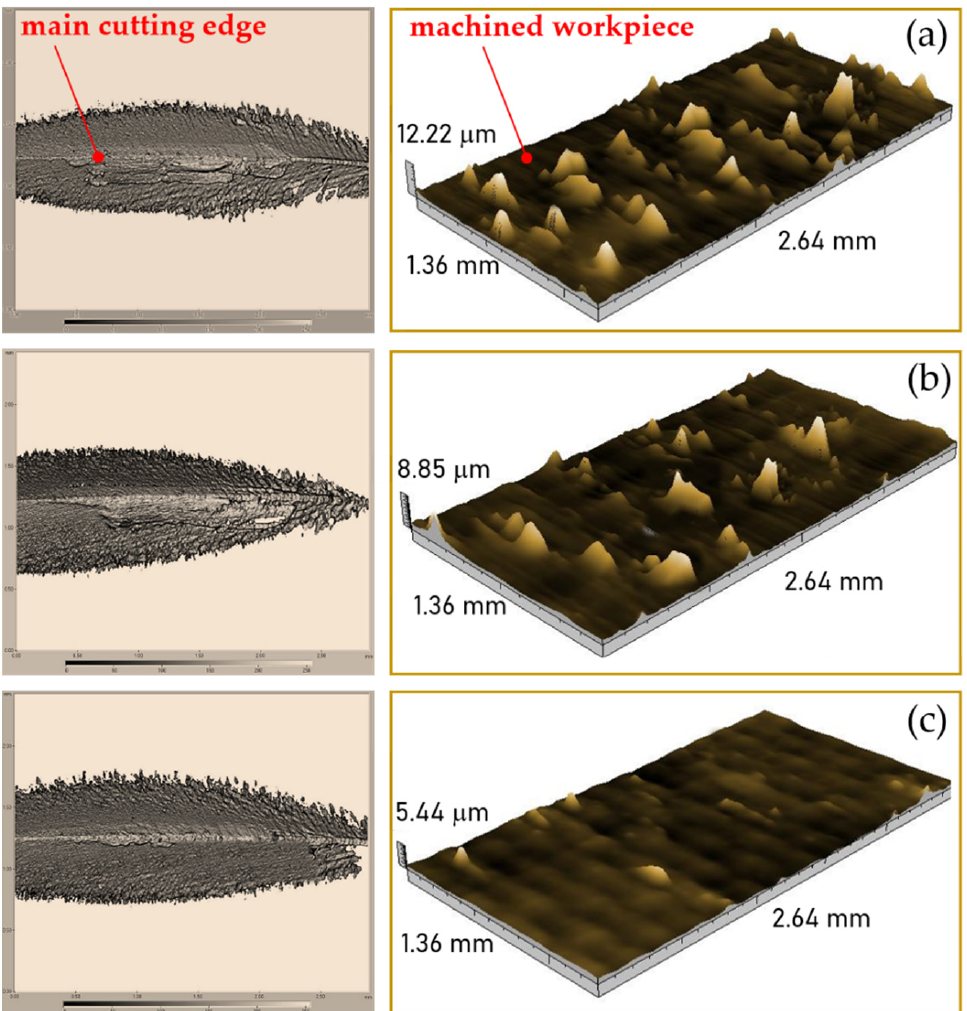
Figure 10. The condition of the main cutting edge of ball end mills and 3D profilograms of the surface condition of a machined nickel alloy workpiece after milling at a cutting speed of 150 m/min with ball end mills with various coatings: ( a ) uncoated; ( b ) with TiN–AlN–TiAlN coating; ( c ) with CrAlSiN–DLC coating.